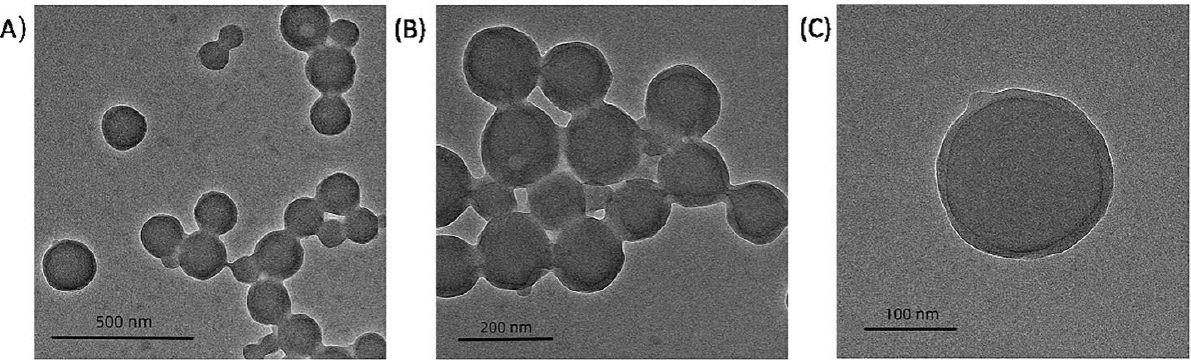
Figure 12. TEM images of emulsion particles: ( A ) scale bar: 500 nm; ( B ) scale bar: 200 nm; ( C ) scale bar: 100 nm.